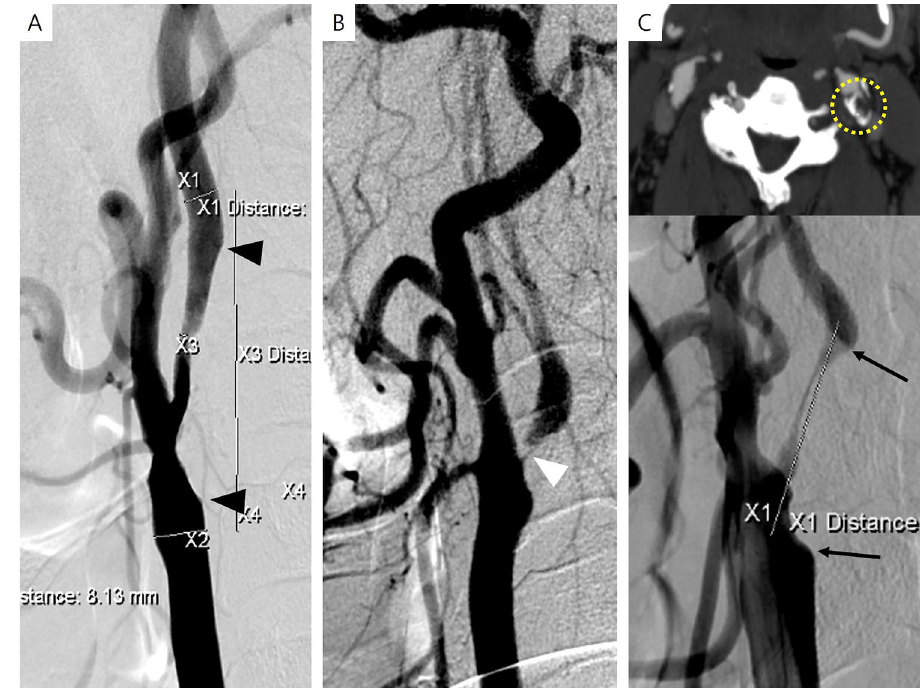
Figure 2. Violation cases. Patients with higher scores for endarterectomy chose to receive stenting rather than endarterectomy. ( A ) A 65-year old male with right symptomatic carotid artery stenosis (79% stenosis) acquired 1 point for favorable CEA [CAS(0) CEA(1)] due to the length of the lesion ≥ 30 mm ( indicated by black arrowheads ). ( B ) A 51-year old female with left symptomatic carotid artery stenosis (99% stenosis) acquired 1 point for favorable CEA [CAS(0) CEA(1)] due to the string sign ( indicated by a white arrowhead ). ( C ) A 59-year old male with left symptomatic stenosis (90% stenosis) acquired 2 points for favorable CEA [CAS(0) CEA(2)] due to the length of the lesion ≥ 30 mm ( indicated by black arrows ) and moderate calcification (90° ≤ circumference < 270°, indicated by a yellow dot-circle